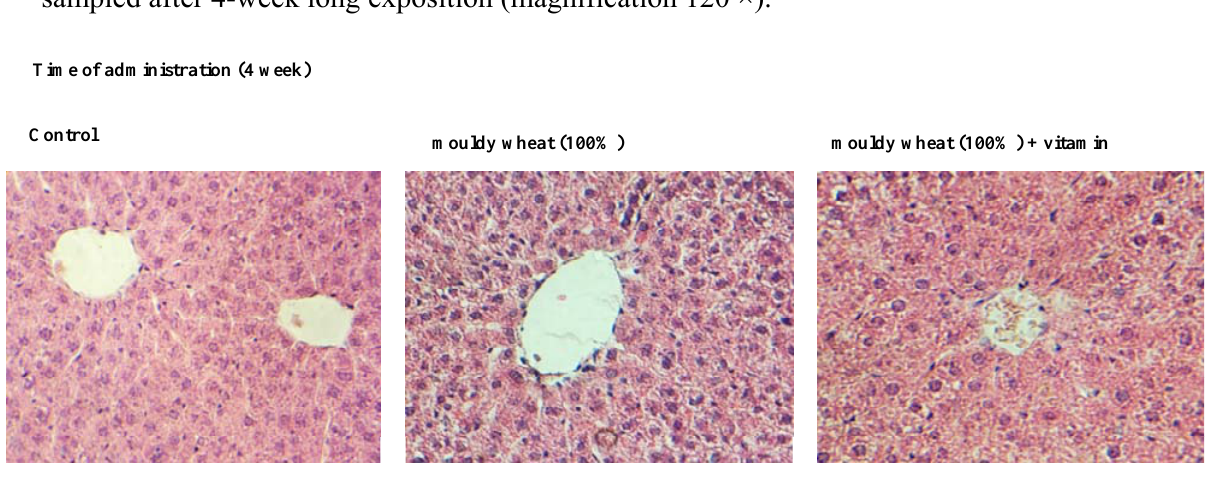
Figure 6. Typical histological changes in hepatic tissue structure in rats. The tissues were sampled after 4-week long exposition (magnification 120 ×).